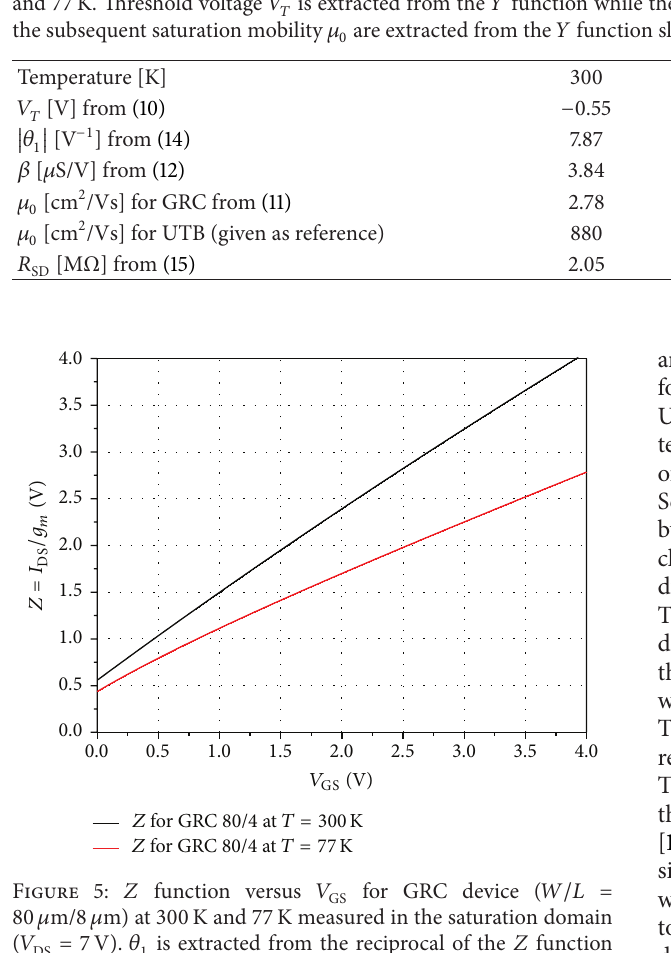
Table 1: Summarizing table of the threshold voltage 𝑉 𝑇 , the 𝑏 slope extracted from the 𝑌 2/3 versus 𝑉 and saturation mobility 𝜇 0 for UTB device at 300 K and 77 K. 𝑉